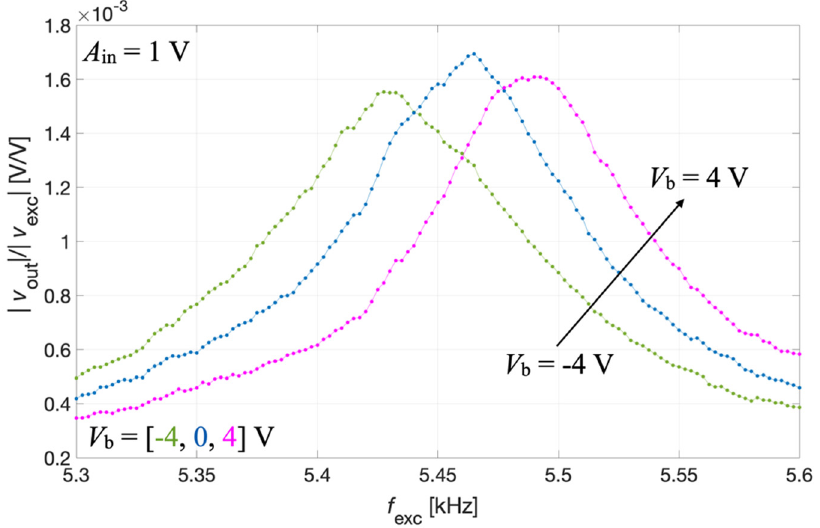
Figure 12. Measured magnitude ratio | v out |/| v exc | as a function of the frequency f exc for the acoustic receiver mode at different values of the bias voltage V b